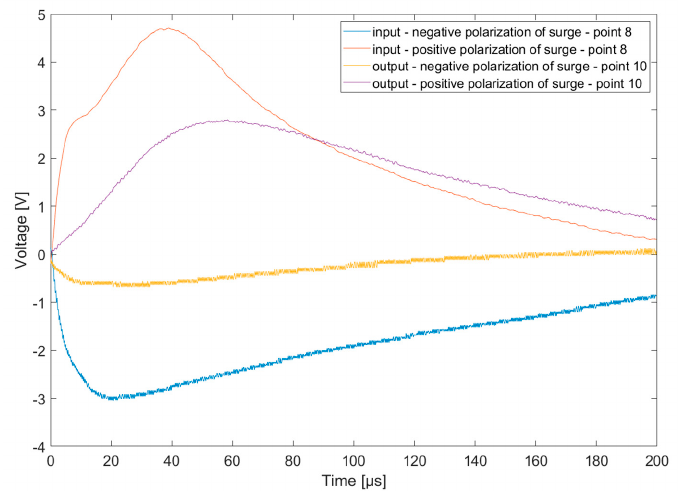
Figure 10. Overvoltage on GPS antenna (point 10) for both (negative and positive) polarity of surge pulse on supply bus (point 8).